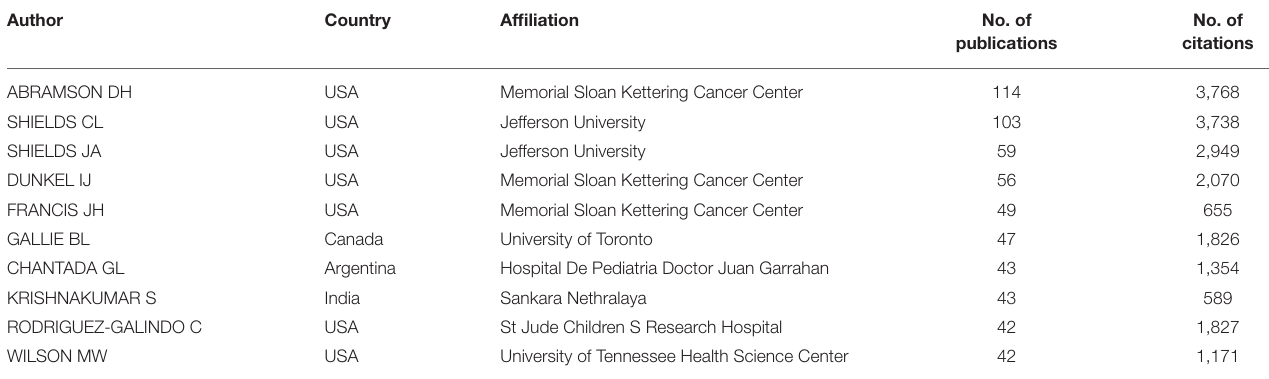
TABLE 1 | Top 10 authors with the most publications in retinoblastoma research.